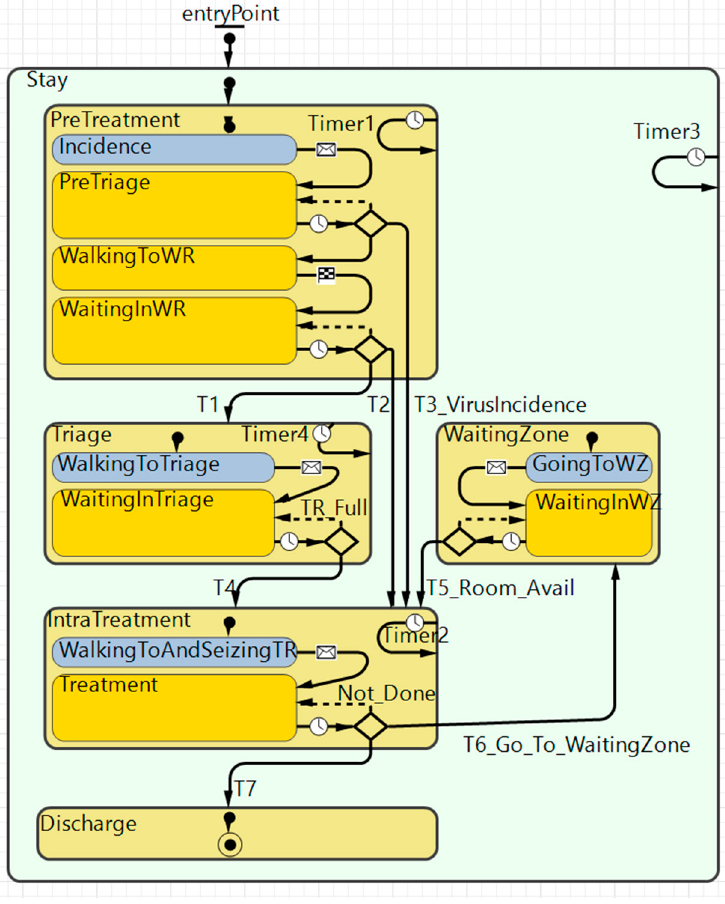
Figure 6. Statechart; the entity that governs the patient flow for every patient agent in the model. Table 2. Overview of terms used to track patient flow performance of the scenarios in this study. Abbreviation Description and Explanation